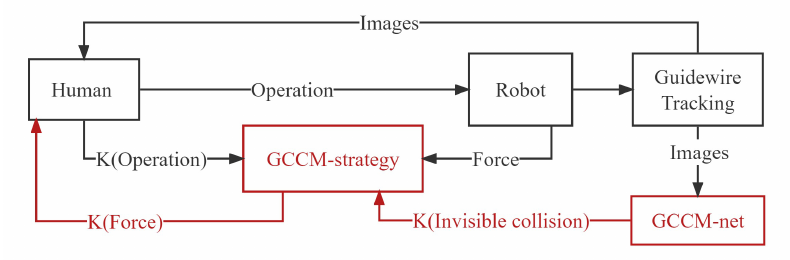
Figure 10. Flow charts of sensors-based and strategy-based force